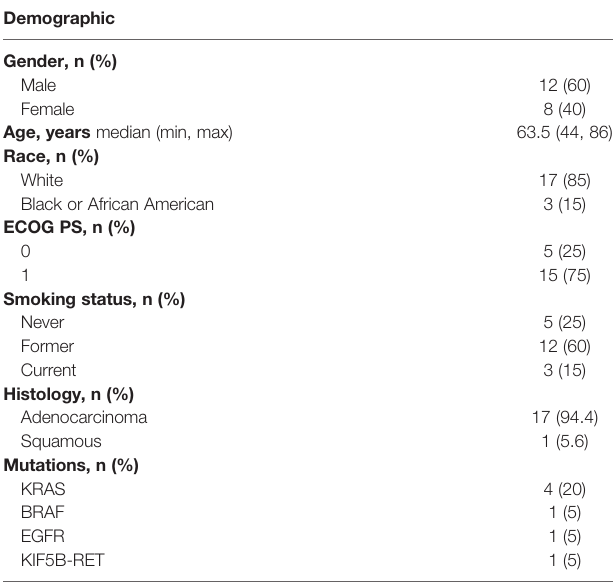
TABLE 1 | Patient demographics and baseline